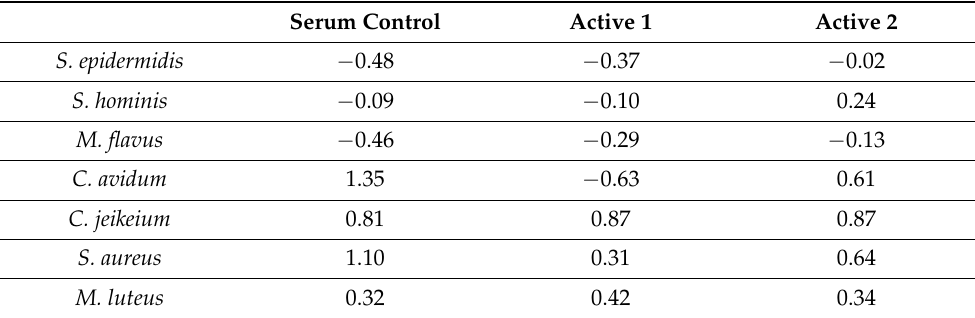
Table 3. Additional effects of active 1, active 2 or the serum control without active. Positive numbers indicate promotion of the respective bacterial strain, while negative numbers mean a reduction compared to the untreated